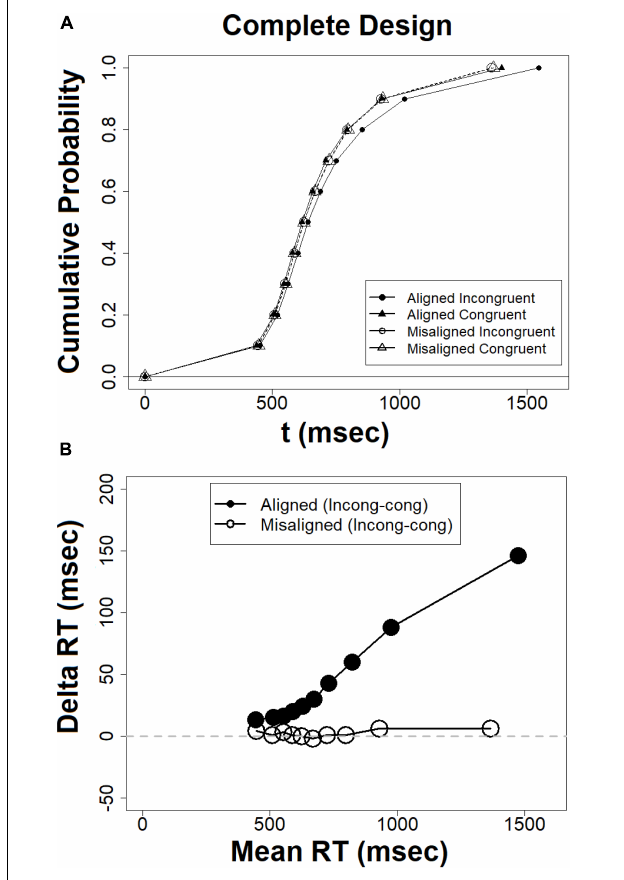
FIGURE 6 | (A) Cumulative probability functions (CDFs) for the complete design, (B) delta plots for the complete design, the abscissa = (mean RT congruent + mean RT